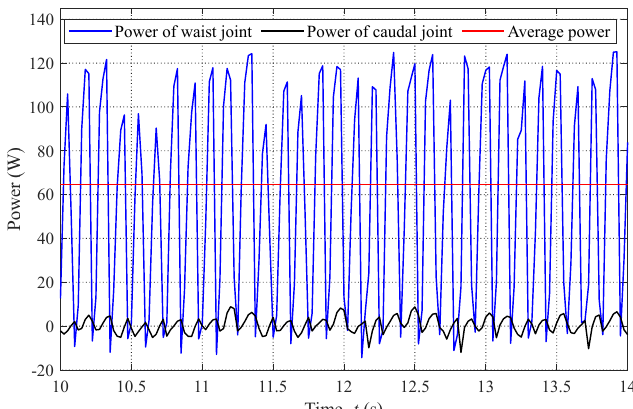
Figure 7. Comparison of power at different swimming depths.